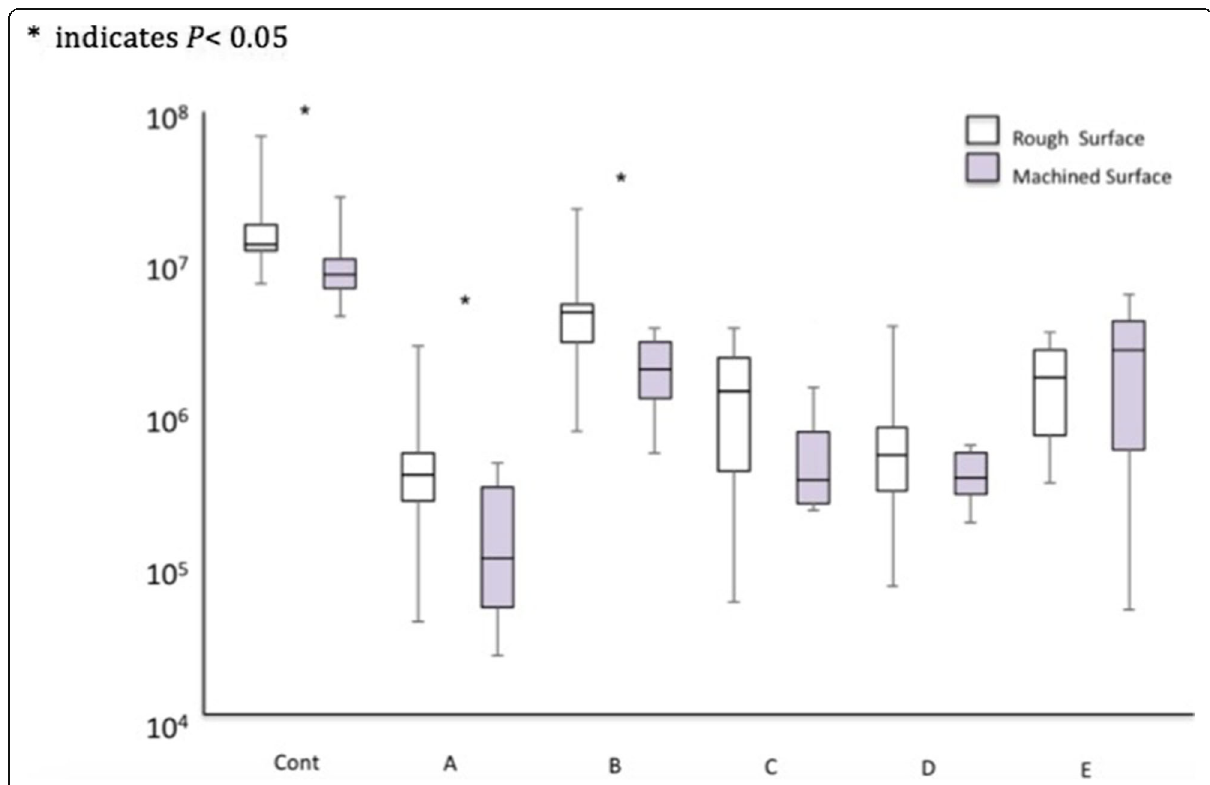
Fig. 6 Comparison of cleansability of each decontamination method on the different implant surfaces. Asterisk indicates p < 0.05